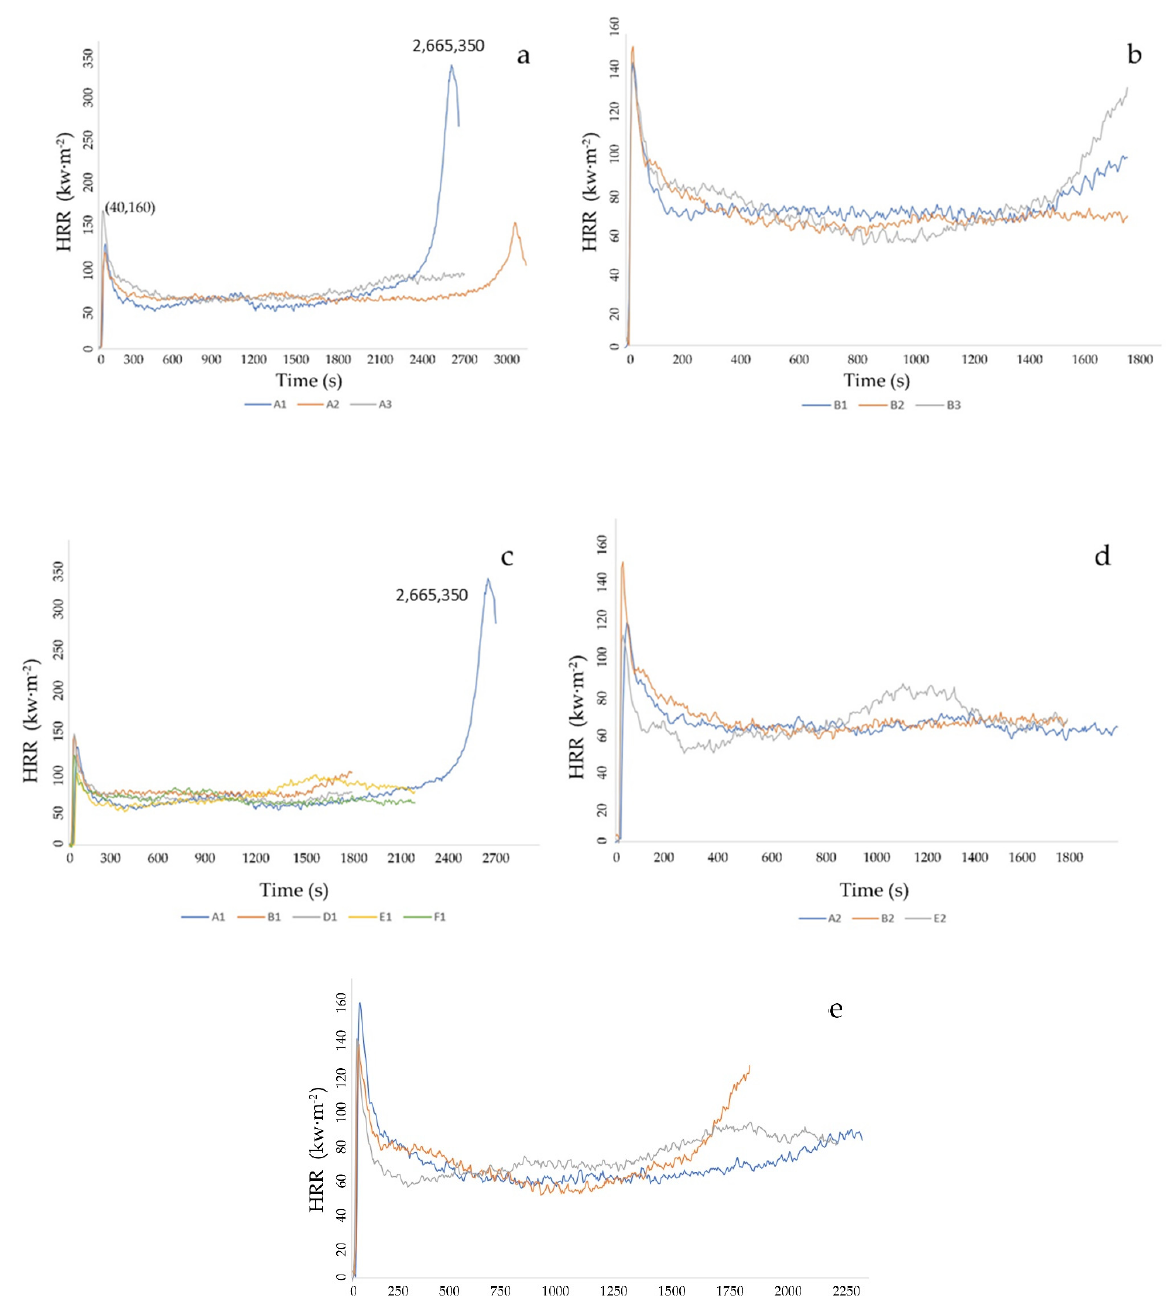
Figure 3. Heat release rate of ancient wood with different fractal dimension classes: ( a ) heat release rate curves for three fractal dimension classes of Ulm, ( b ) heat release rate curves for three fractal dimension classes of Larch wood, ( c ) heat release rate curves for five specimens with fractal dimension class 1, ( d ) heat release rate curves for three specimens with fractal dimension class 2, ( e ) heat release rate curves for three specimens with fractal dimension class 3.